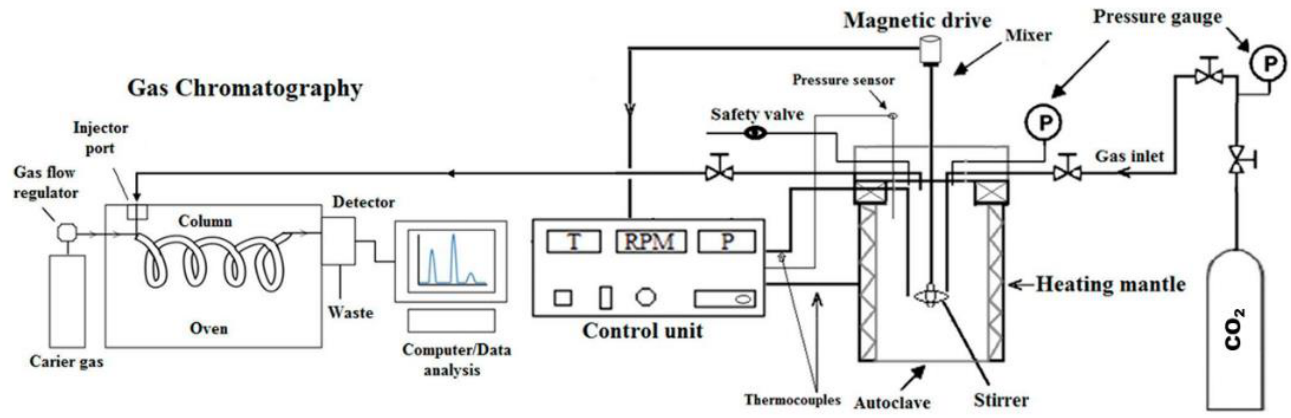
Figure 1. Schematic illustration of experimental